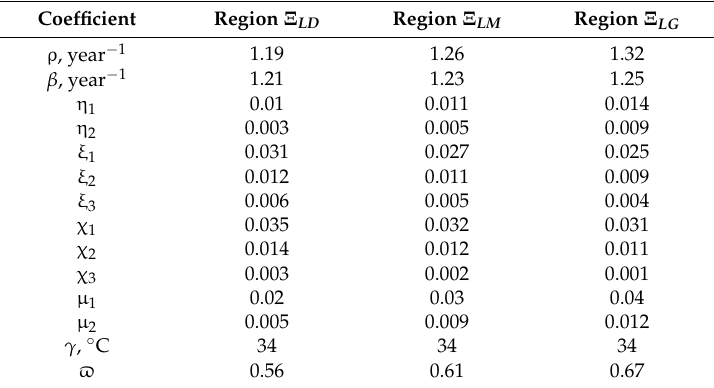
Table 4. Coefficients of the GIMS/CNSS for the land